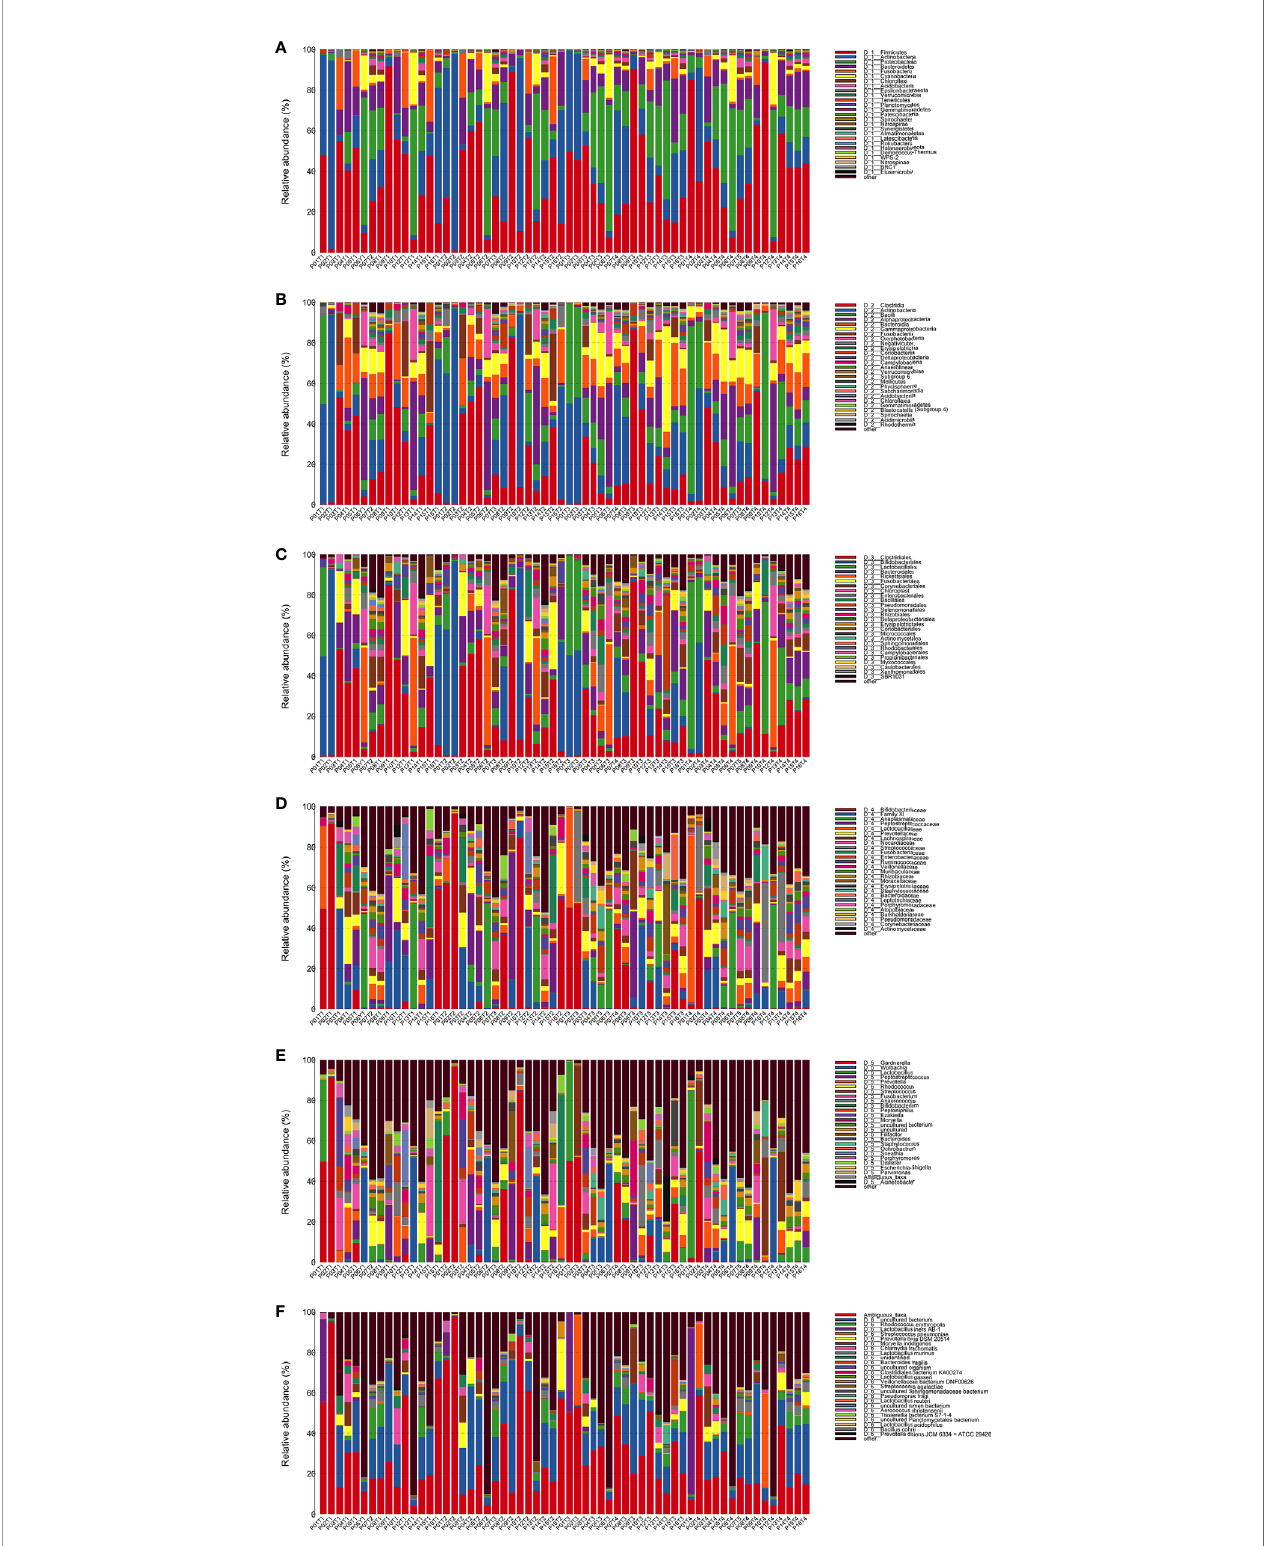
FIGURE 4 | Distribution of bacterial phyla (A) , classes (B) , orders (C) , families (D) , genera (E) , and species (F) obtained by next-generation sequencing of samples from 15 patients at four time